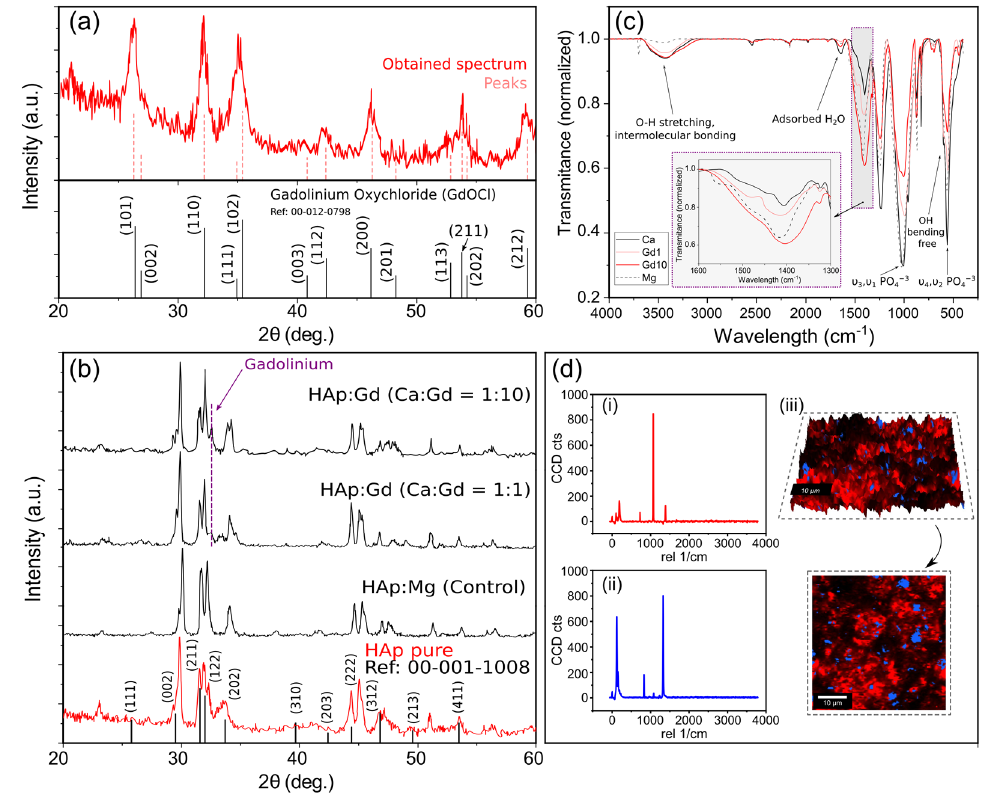
Figure 4. ( a ) X-ray diffraction obtained for the resultant material from the hydrolysis reaction of GdCl 3 . Major peaks correspond to Gadolinium Oxychloride (ICDD Ref: 00-012-0798), corroborating the chemical reactions predicted by the bibliography. ( b ) FTIR spectra obtained for the four studied samples. In the inset, the critical range of 1600–1400 is zoomed in. ( c ) X-ray diffraction curves for the different samples. As expected, the Sample with a higher concentration of Gd in the initial step of the synthesis, produces a higher peak at 2 θ = 32.547° (lattice parameters: a= 3.614 Å, b = 3.614 Å, c = 5770 Å and indices (h k l) = (1 0 1)), Probing a successful substitution of Gd in the Ca sites. ( d ) Raman spectra in the 0–4000 cm − 1 wavenumber range of HAp:Gd1. Spectra (i) and (ii) represent the two main bands detected by the software. Figure (iii) shows the optical images of the compound